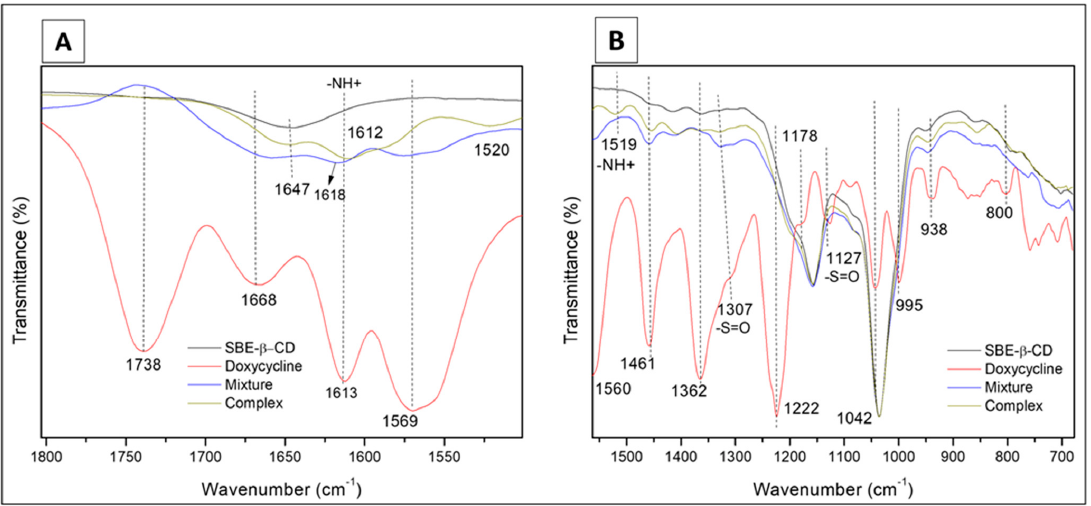
Figure 4. Infrared spectra from 1800 to 1500 cm − 1 ( A ) and 1560 to 700 cm − 1 ( B ) of samples of doxycycline (DX), sulfobutylether- β -cyclodextrin (SBE- β -CD), physical mixture, and freeze-dried complex (1:1 molar ratio).